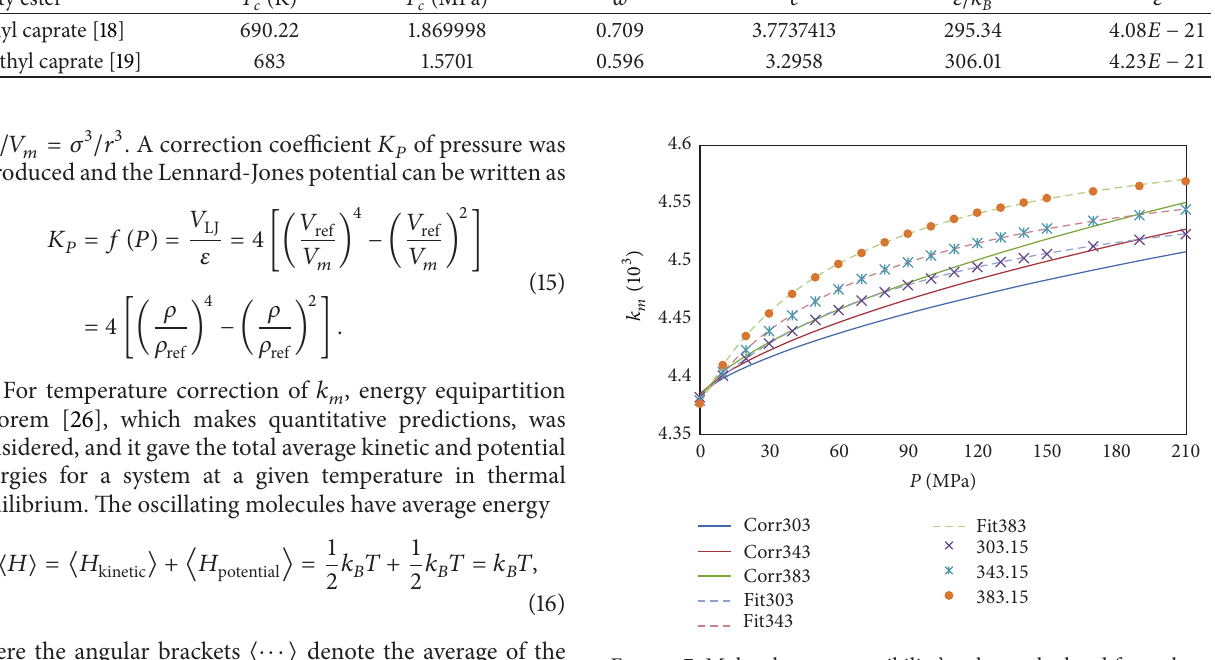
Figure 7: Molecular compressibility’s values calculated from three formulas for methyl caprate along various isothermals (dots for (8), dotted lines for (13), and lines for